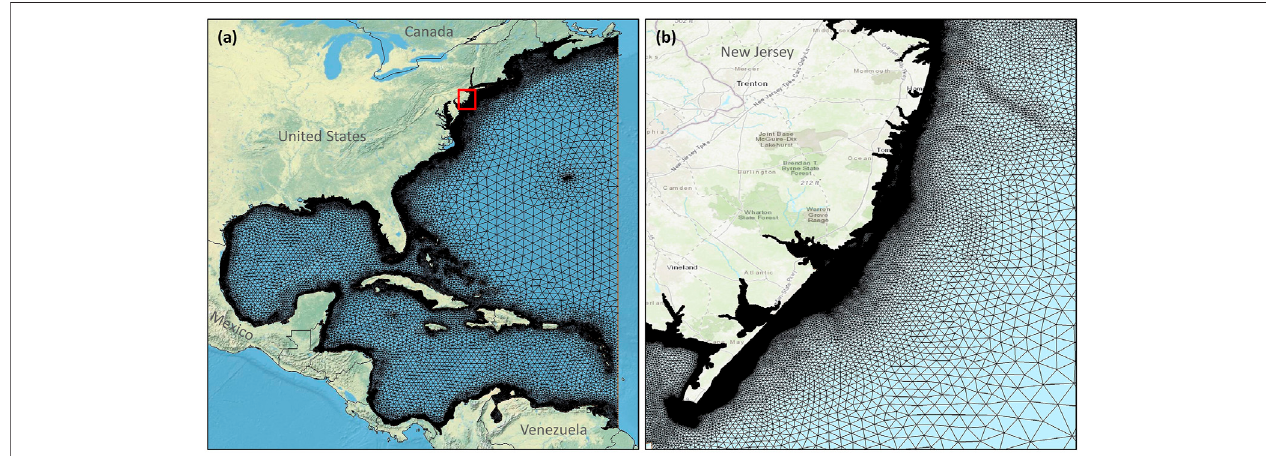
FIGURE3|(A) ComputationalmeshoftheADCIRC-SWANmodelusedinthepresentstudy. (B) Closeupviewofthecomputationalmeshinthestudyarea(thered box in panel a).